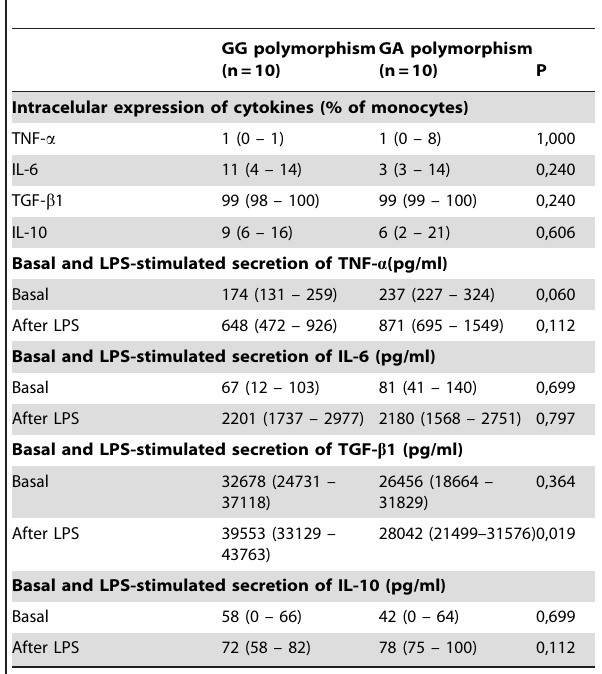
Table 4. Intracellular expression of tumor necrosis factor alpha, interleukin 6, transforming growth factor beta1 and interleukin 10 by monocytes from healthy individuals distributed in function of the -238 promotor gene